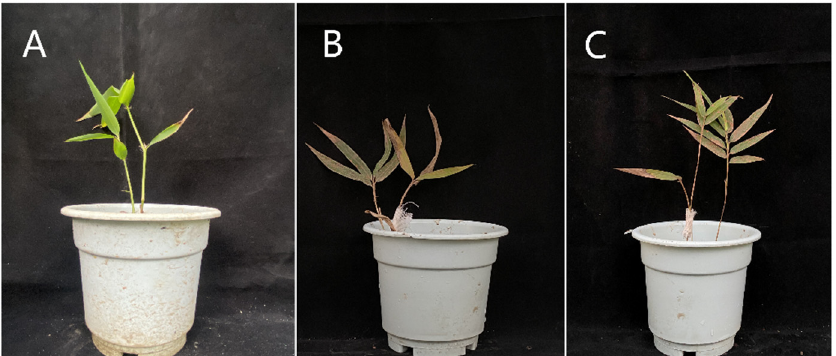
Figure 7. Symptom chart of different strains of 3-month-old B. pervariabilis × D. grandis after inocu- lation with pathogenic A. phaeospermum . ( A ): wild-type B. pervariabilis × D. grandis ; ( B ): cof-RNAi, ( C ): cad-RNAi.